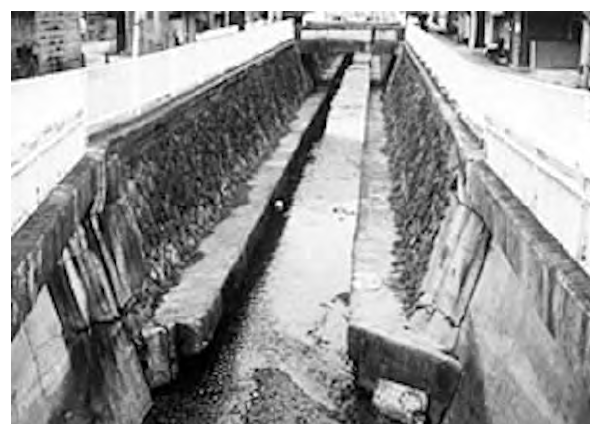
Figure 9. Nanase River, before intervention Source: Kyoto City Official Website